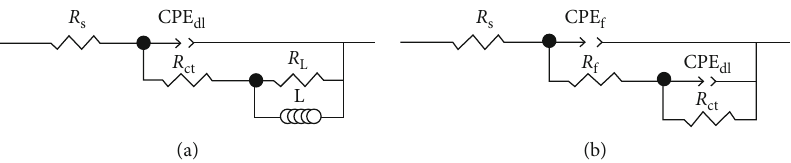
SO in the presence of the Sn-metallic complex in 2 4 SO at di ff erent concentrations of Sn- 2 4